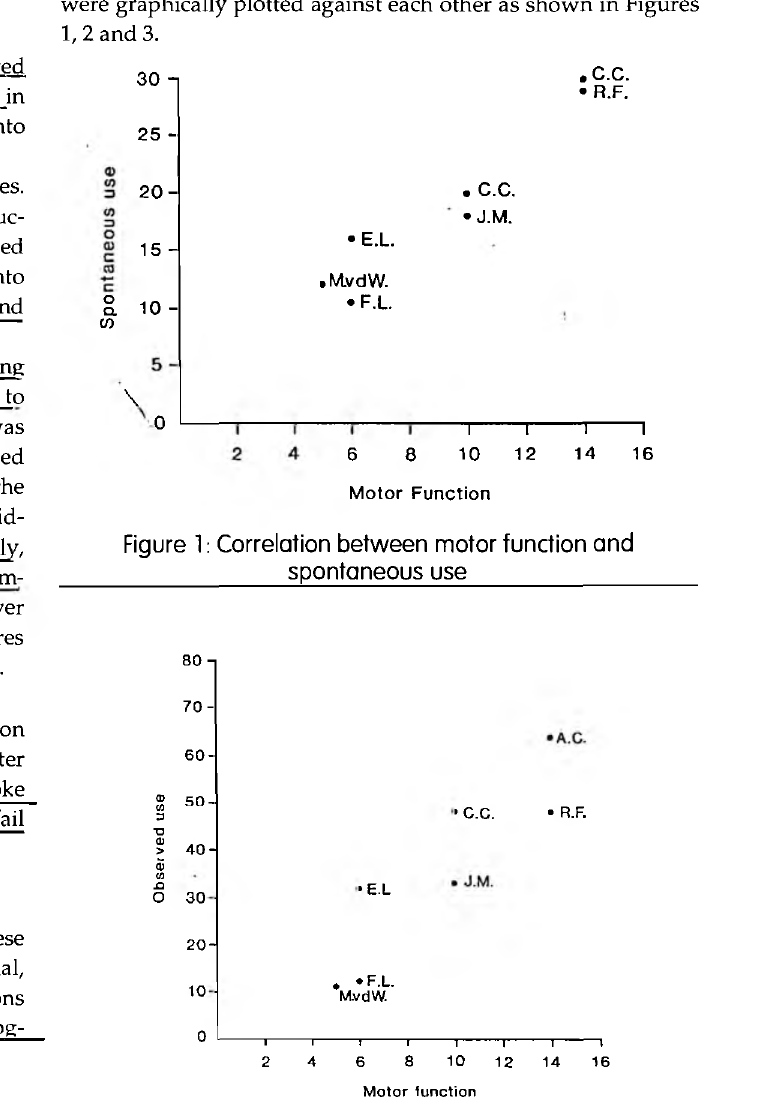
Figure 2: Correlation between motor function and